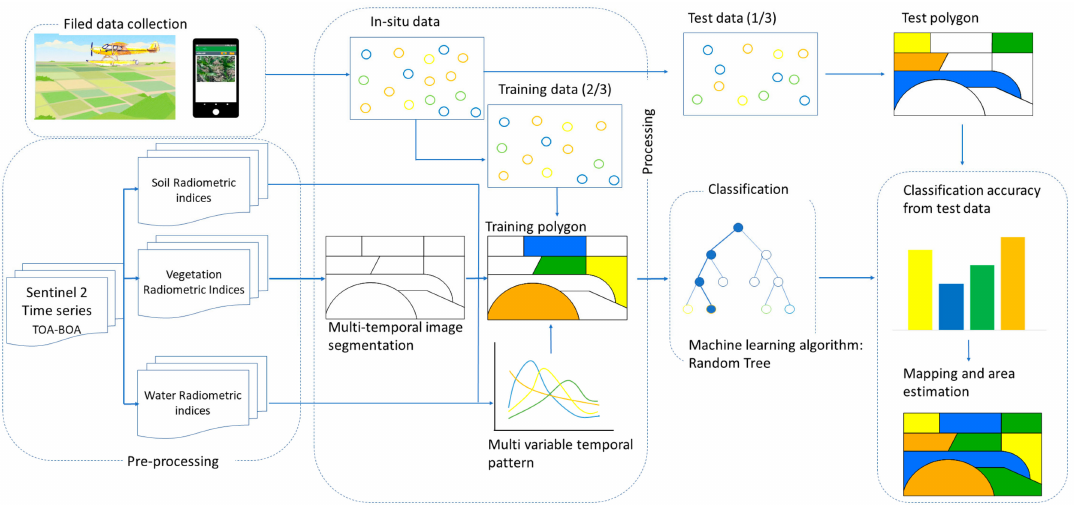
Figure 2. Workflow of object-based machine learning approach for mung bean classification in Barisal division in coastal Bangladesh.